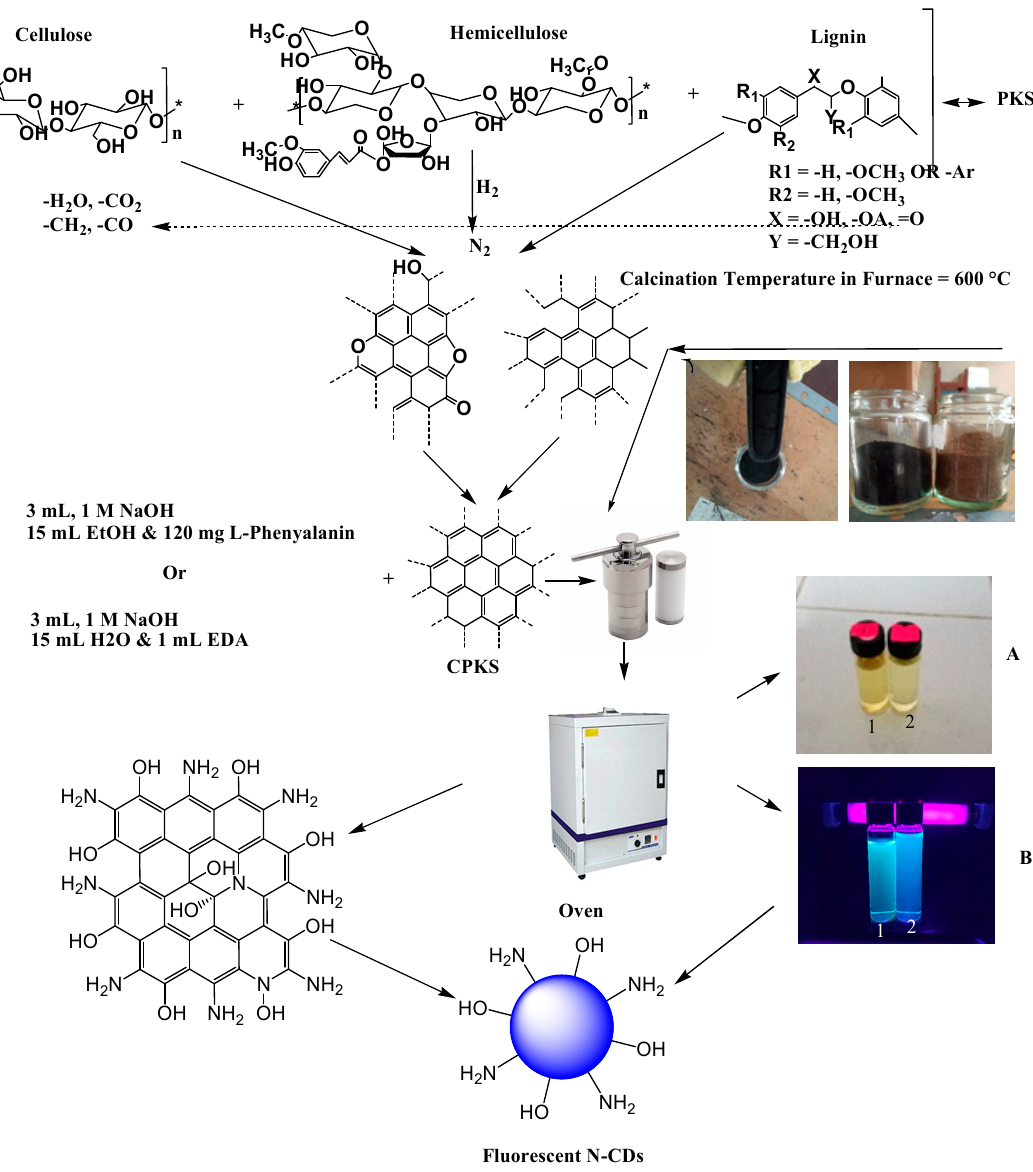
Figure 1. Illustration of the process of one-pot hydrothermal synthesis of N-doped synthesized CDs.